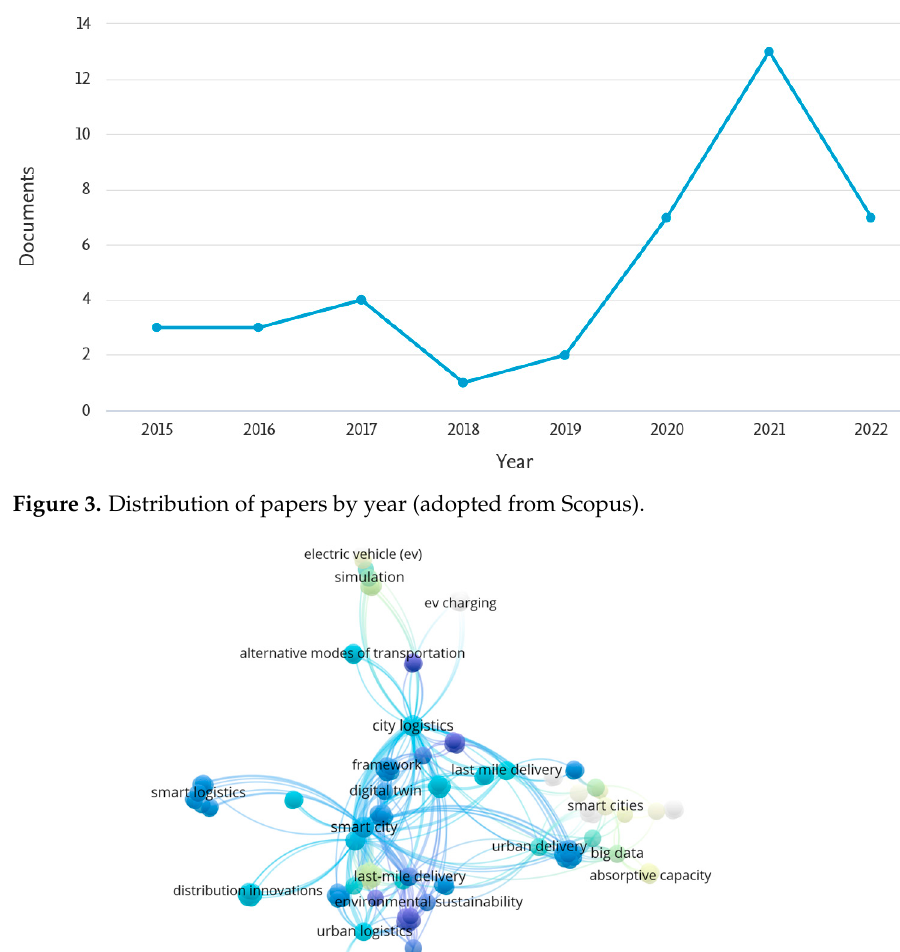
Figure 4. Evolution of the topics based on the keywords.